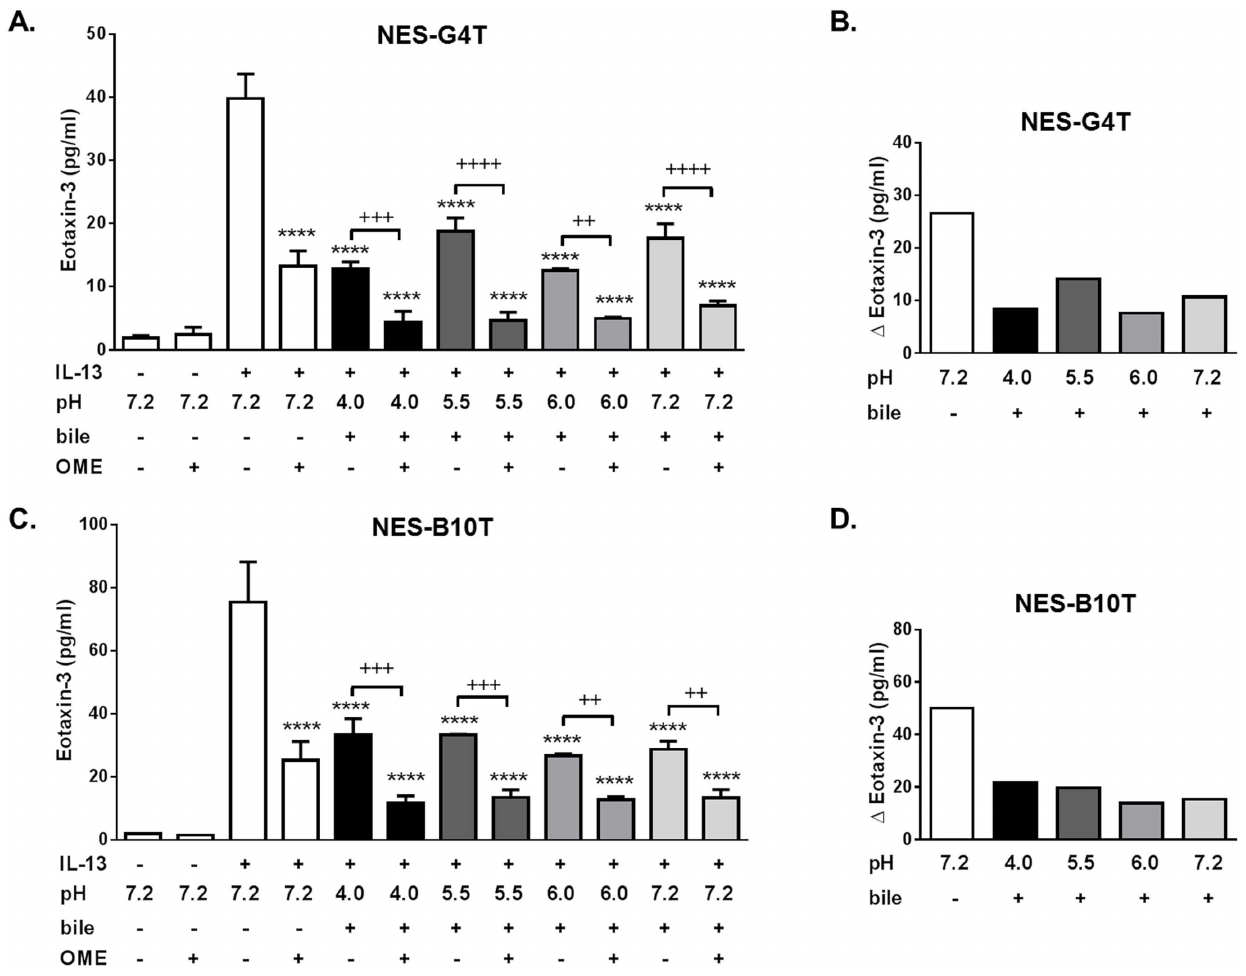
Figure 8. Acid and bile salt effects and PPI anti-inflammatory effects on IL-13-induced eotaxin-3 protein secretion in GERD cells. (A) Combined effects of acid-bile salt medium and omeprazole (OME) on IL-13-induced eotaxin-3 protein secretion in NES-G4T. Data are mean 6 SEM of 2 experiments. ****P , 0.0001 compared to IL-13 alone (pH 7.2, no bile, no OME). ++ P , 0.01, +++ P , 0.001, ++++ P , 0.0001. (B) Graph depicts the magnitude of the decrease in IL-13-stimulated eotaxin-3 secretion achieved by omeprazole for each acid-bile salt exposure condition in NES-G4T. (C) Combined effects of acid-bile salt medium and omeprazole on IL-13-induced eotaxin-3 protein secretion in NES-B10T. Data are mean 6 SEM of 2 experiments. ****P , 0.0001 compared to IL-13 alone (pH 7.2, no bile, no OME). ++ P , 0.01 and +++ P , 0.001. (D) Graph depicts the magnitude of the decrease in IL-13-stimulated eotaxin-3 secretion achieved by omeprazole for each acid-bile salt exposure condition in NES-B10T.